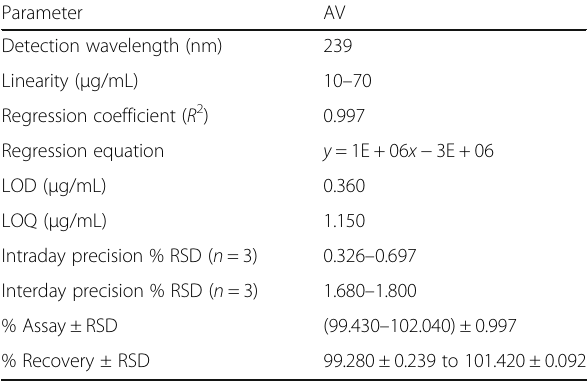
Table 5 Summary of validation parameter of SIAM of